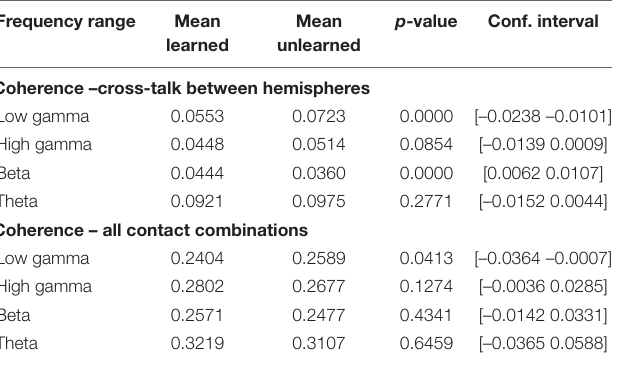
TABLE 1 | Inter- and intra-hemispheric functional connectivity, as measured by magnitude-squared coherence. Frequency range Mean Mean p -value Conf. learned unlearned